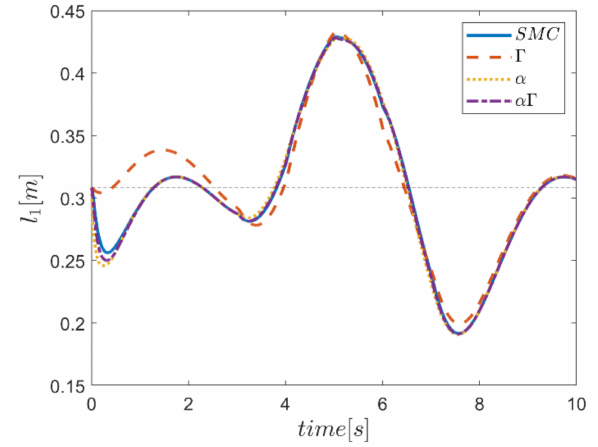
Figure 34. Comparison of the length of the first actuator.